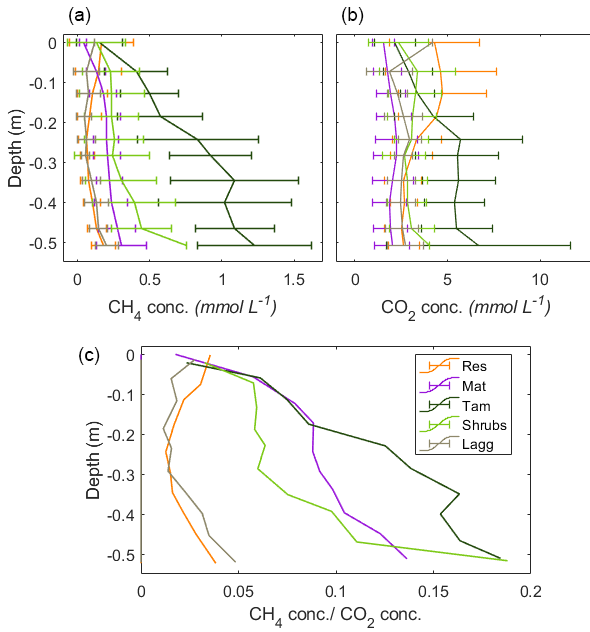
Figure B3. Vertical profiles of CH 4 and CO 2 pore-water concentrations (a, b) and the resulting CH 4 : CO 2 ratios (c)